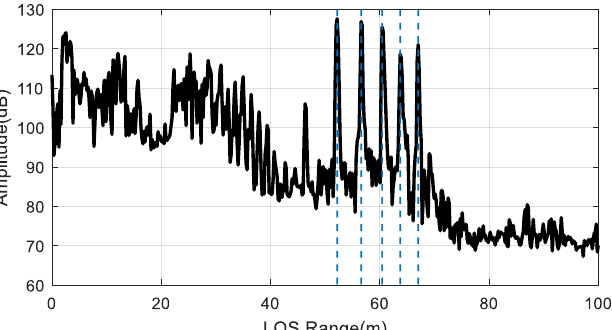
Figure 7. High resolution 1D radar image of the five cables. The five peaks are among 45 m to 70 m, which correspond to the five longest cables in a red color in Figure 6.